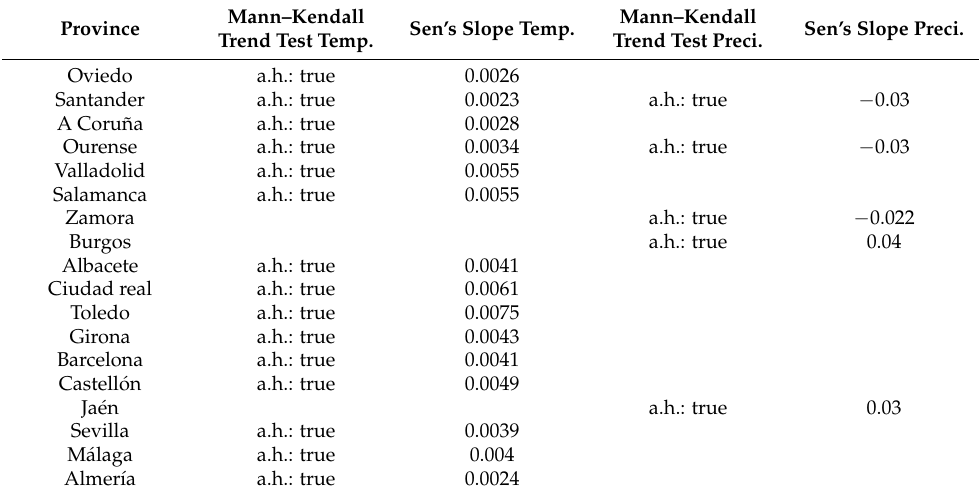
Table 3. Summary of results of the Mann–Kendall trend test and Sen’s Slope.